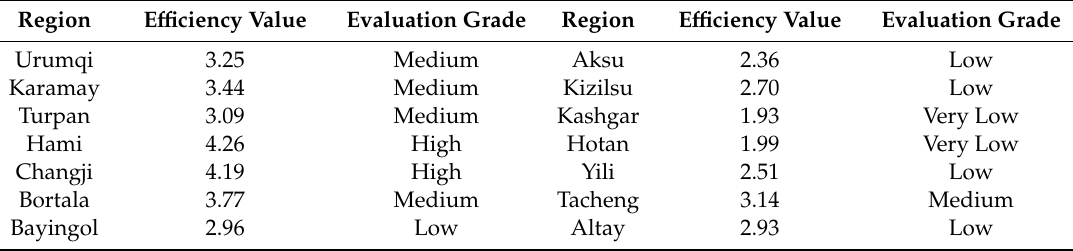
Table 8. Agricultural water use e ffi ciency values and evaluation grades of 14 administrative regions. Region E ffi ciency